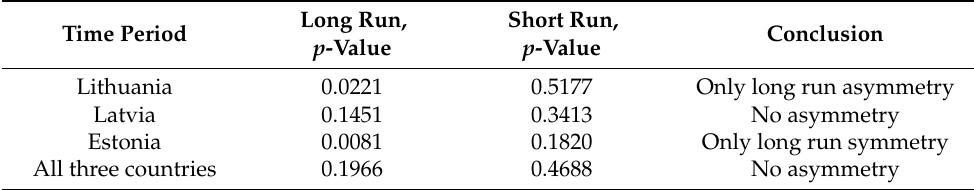
Table 3. Long-run and short-run symmetry test